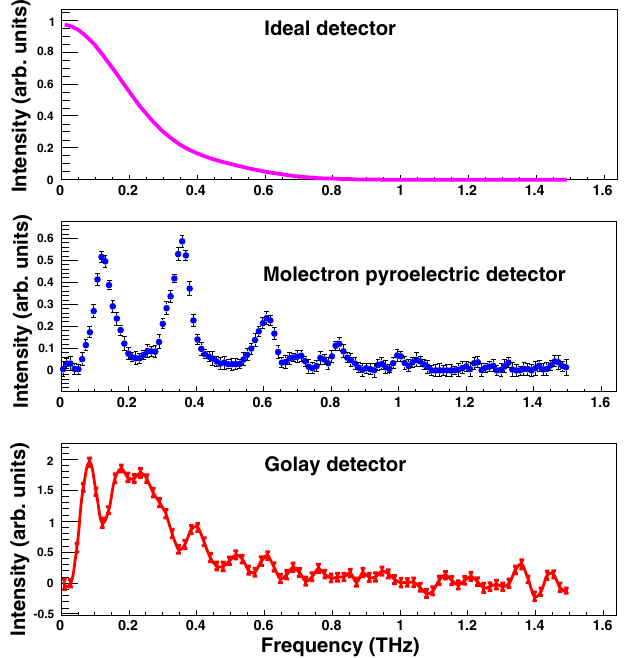
FIG. 5. (Color) Intensity spectra for ideal (top), pyroelectric (middle), and Golay (bottom) detectors. Vertical axis has arbi- trary units.